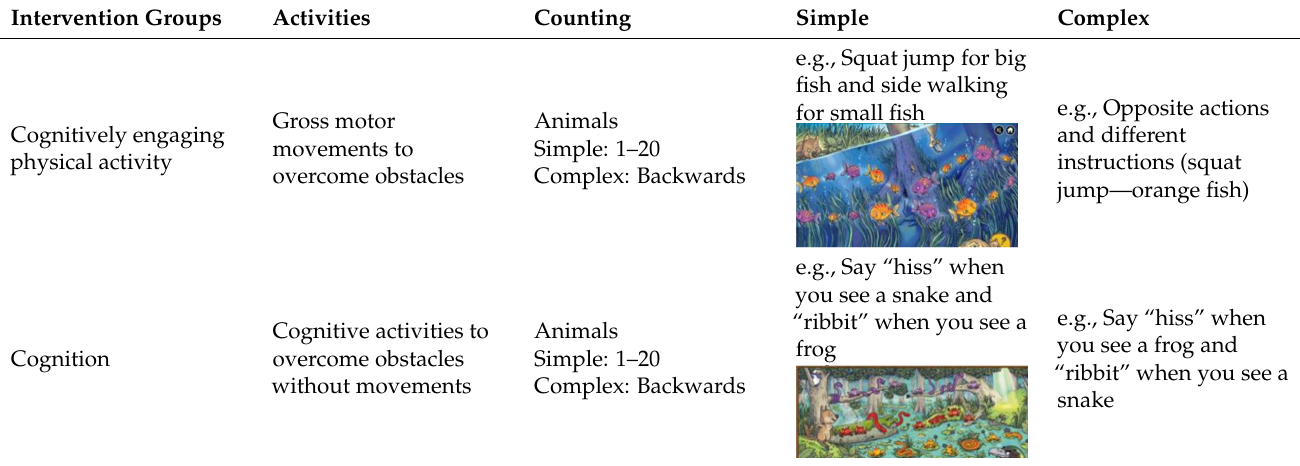
Table 2. Examples of activities per intervention